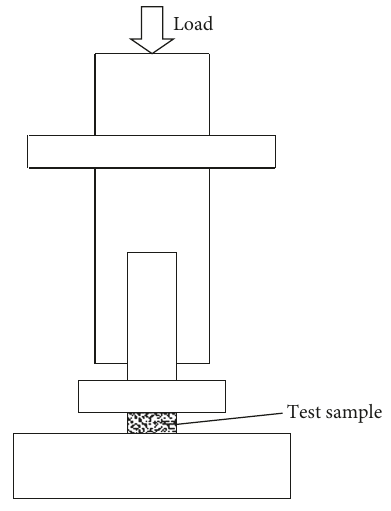
Figure 2: Schematic of compression